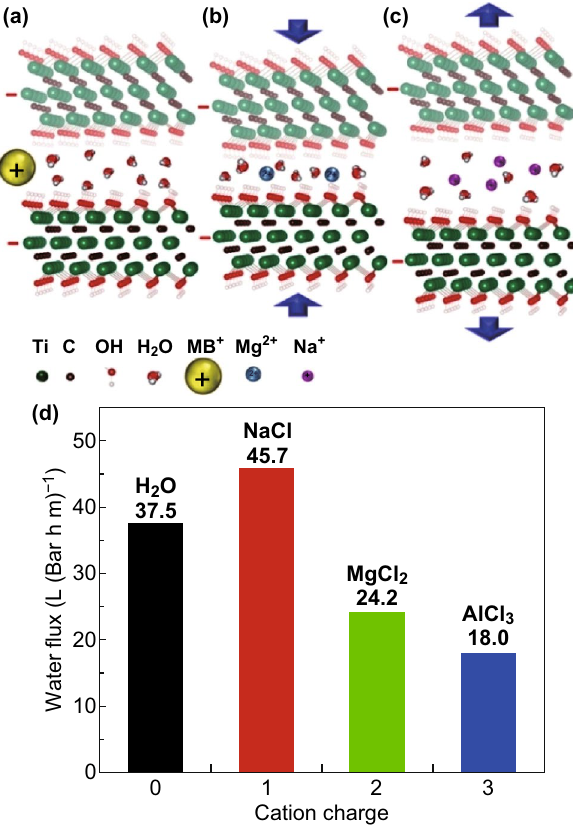
Fig. 3 Schematics of the permeation of cations through a Ti 3 C 2 T x membrane and total rejection of large MB + . a Cations of radii > 6.4 Å cannot penetrate into interlayer spacing. b Shrinkage of spac- ing between Ti 3 C 2 T x layers due to the intercalation of smaller mul- tiple-charged cations that result in slower permeation. c Expansion of Ti 3 C 2 T x interlayer spacing due to the intercalation of small single- charged cations that result in faster flow. d The flux of salt solutions and water through the Ti 3 C 2 T x membranes versus cation’s charge. Reprinted with permission from Ref. [36]. Copyright © (2015) American Chemical